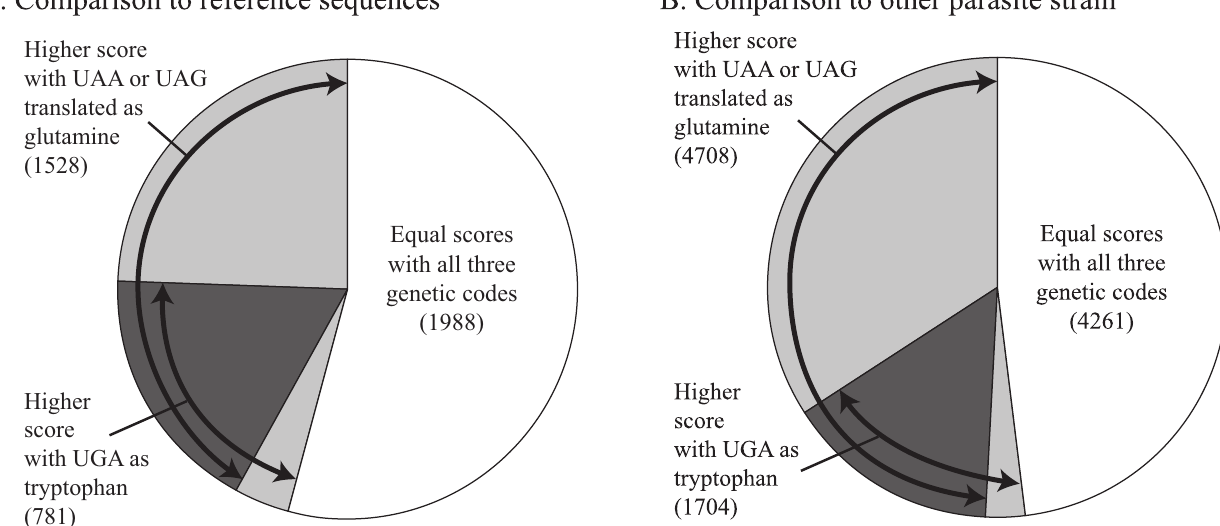
Fig 2. Proportions of BLASTx hits producing different raw pairwise scores when translated with three genetic codes. A. BLAST using the high AT content, putative parasite, sequences as queries and the NCBI reference sequence database as the subject (3,652 hits) or the translated transcriptome data from Amoebophrya sp. ex Akashiwo sanguinea as the subject (9,589 hits). For the comparison with the reference sequence database 3,652 queries with e-values � 10 − 10 roughly half (unshaded portion) had equal scores with all three genetic codes. Of the remaining sequences, most contained UAA or UAG codons which, when translated as glutamine increased the BLASTx score (light grey shading). Many of these sequences also contained UGA with increased scores when translated as tryptophan (darkest shading contains both UGA and UAA or UAG). A small fraction of the UGA-containing sequences did not have increased scores when UAA or UAG were translated as glutamine (light grey